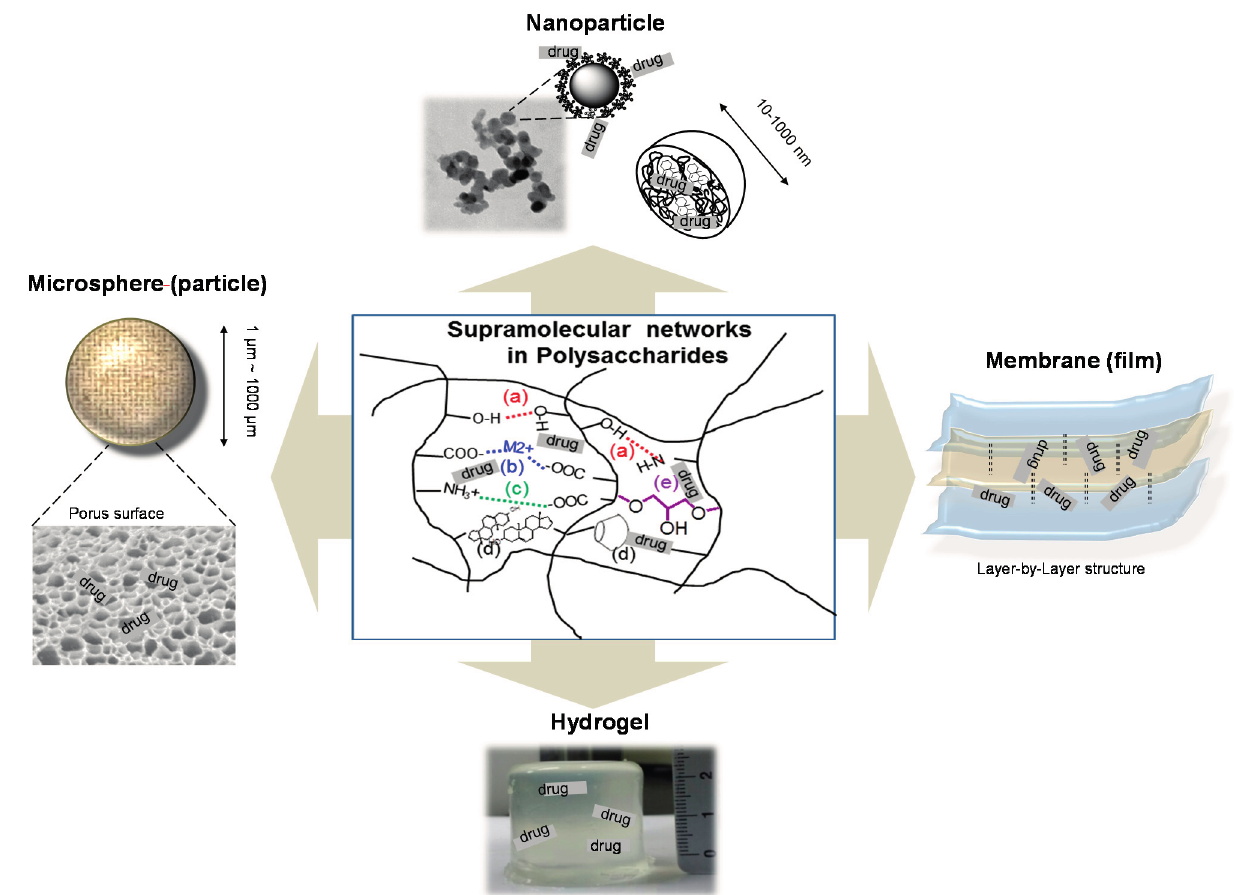
Figure 3. Polysaccharide-based advanced materials and supramolecular architectures for biomedical applications. The supramolecular architecture is formed by noncovalent methods such as hydrogen bonding ( a ); metal coordination ( b ); ionic interaction ( c ); hydrophobic interaction ( d ); and covalent methods using cross-linkers ( e